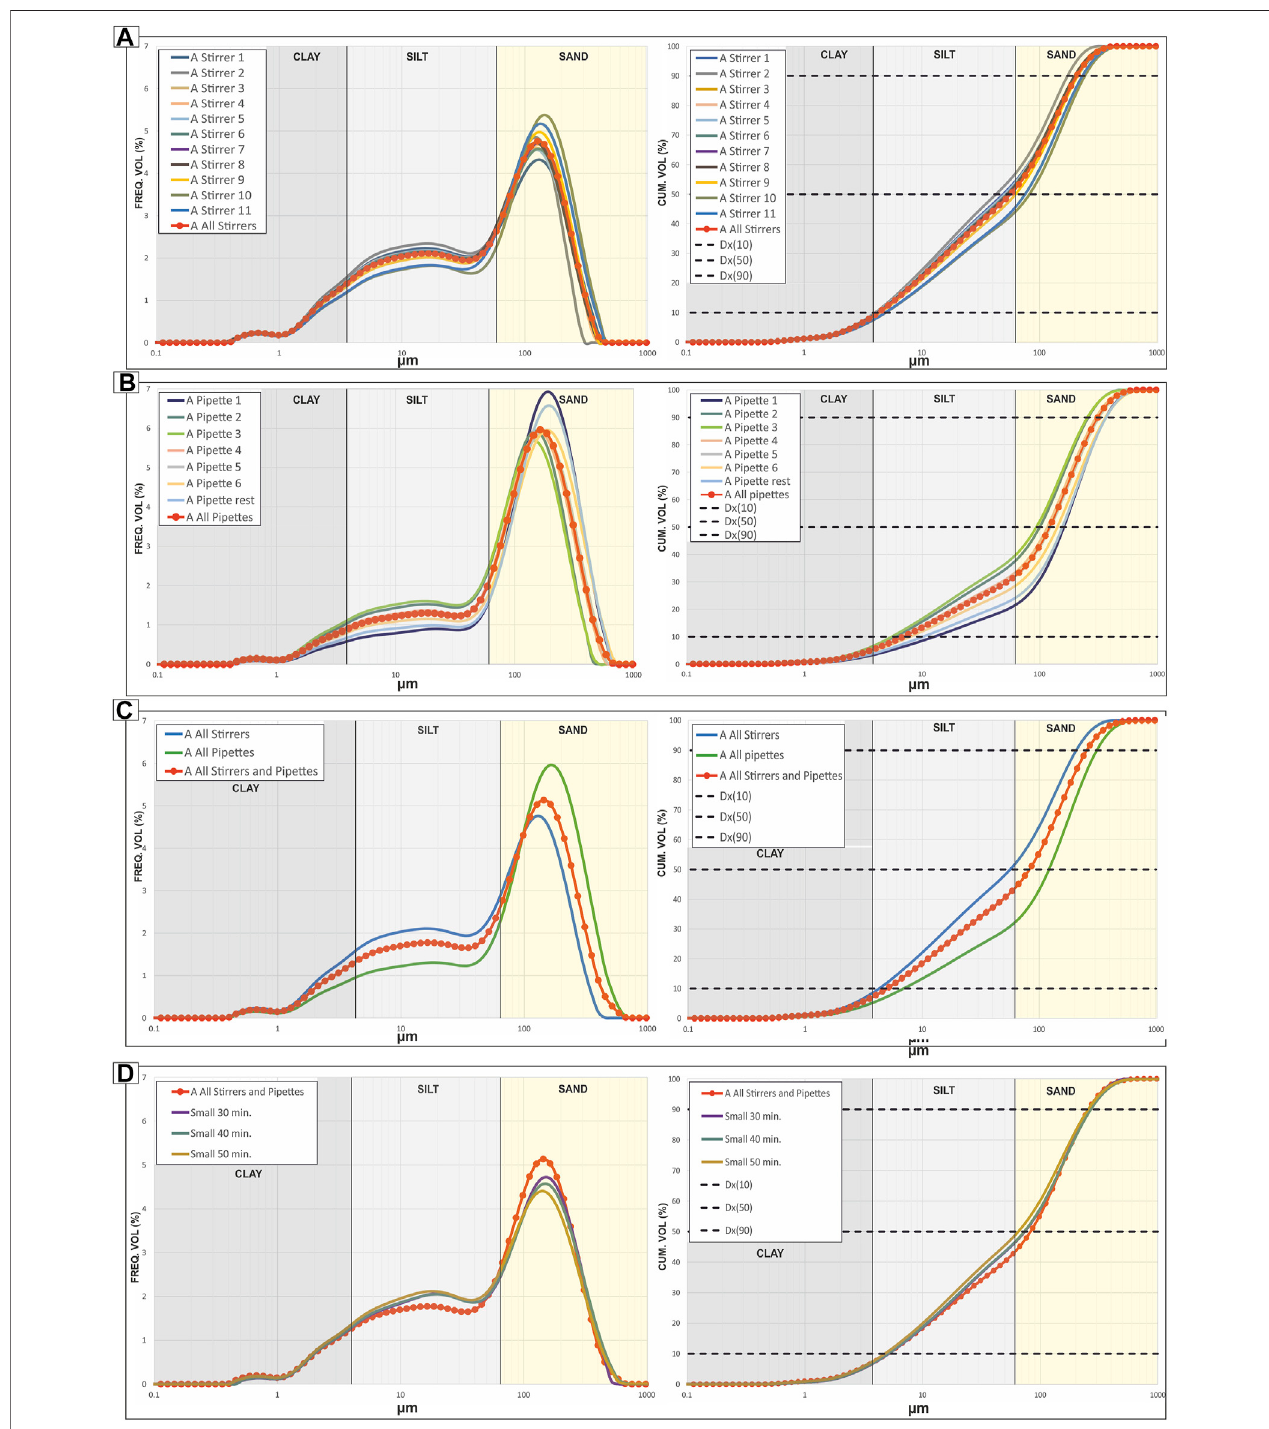
FIGURE8| Volumefrequency and cumulative frequencygraphsshowing aliquotsfor sand-rich fi eld sample IIB209S 9,Sub-sampleA, showing aliquots from the establish Pipette and Stirrer methods. (A) Stirrer aliquots 1 – 11 and average of all stirrer aliquots. (B) Pipette aliquots 1 – 7 and average of all pipette aliquots. (C) Comparisonofstirrerandpipetteaveragesandaveragesforallsub-sampleAaliquots. (D) AverageofallsubsampleAstirrersandpipettescomparedto3smallsamples (taken from the time test in Figure 5 ). For detailed results Supplementary Table S1 , for p -values Supplementary Table S2 .